Question: Condense the content of this figure into a single sentence.
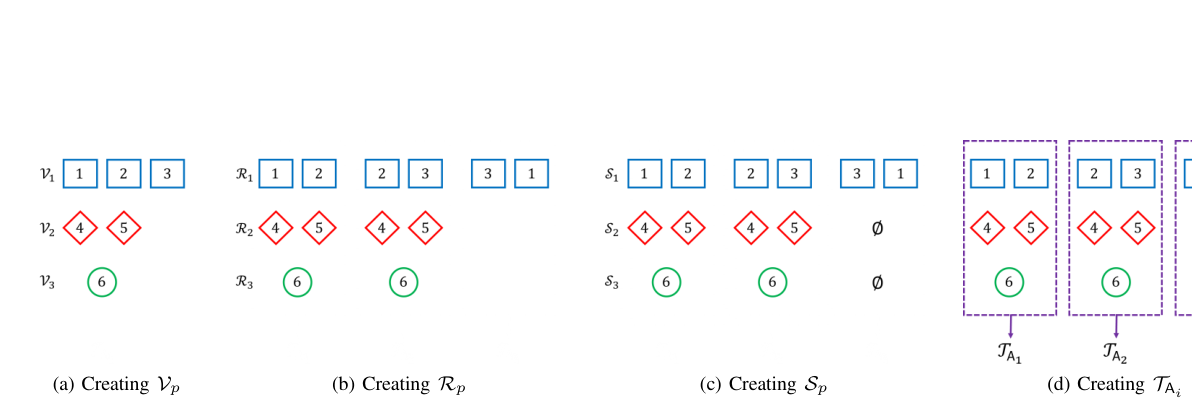
Answer: The elevation process to create the set of served users during the transmission triple Ai for Strategy A in a network with γ = 2